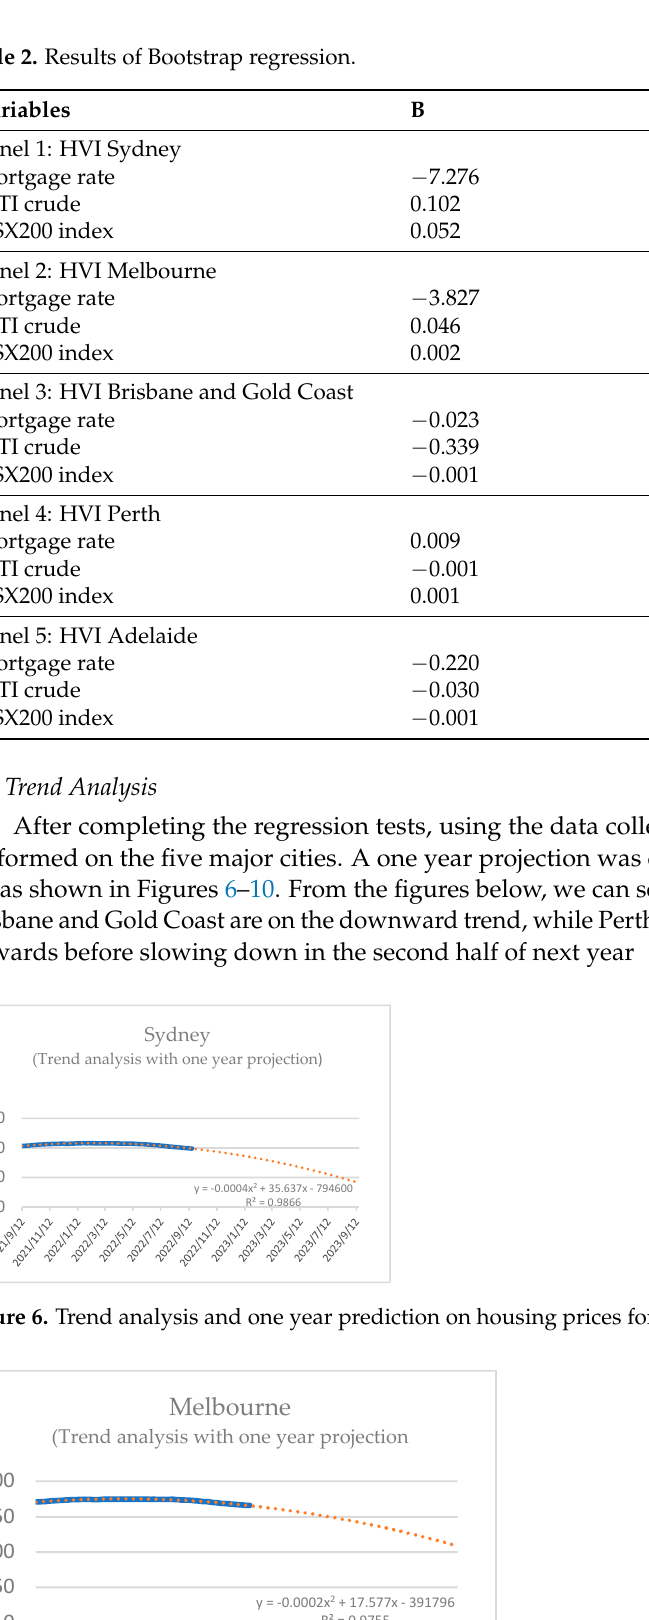
Figure 7. Trend analysis and one year prediction on housing prices for Melbourne.